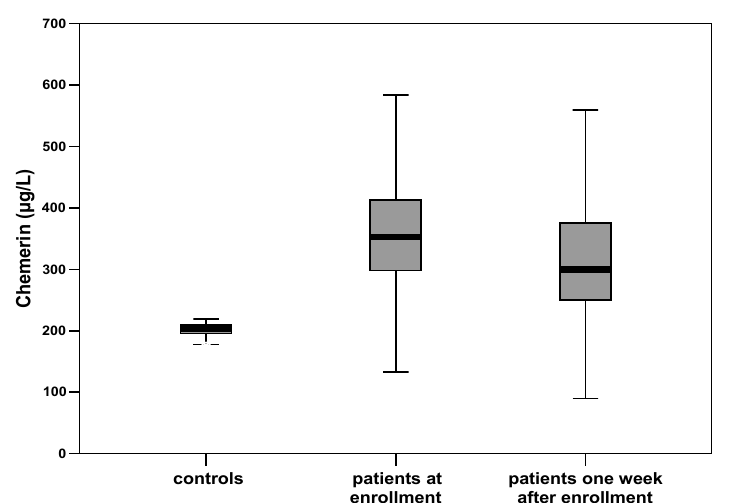
Figure 2. Box plots of circulating chemerin in healthy controls and in septic patients at enrollment and one week after. At enrollment, septic patients present a significantly higher mean level of chemerin than controls (342.3 ± 108.1 μ g/L vs. 200.8 ± 40.1 μ g/L, p < 0.001). Circulating levels of chemerin in septic patients decrease significantly one week after enrollment (342.3 ± 108.1 μ g/L vs. 308.2 ± 108.5 μ g/L, p < 0.001).